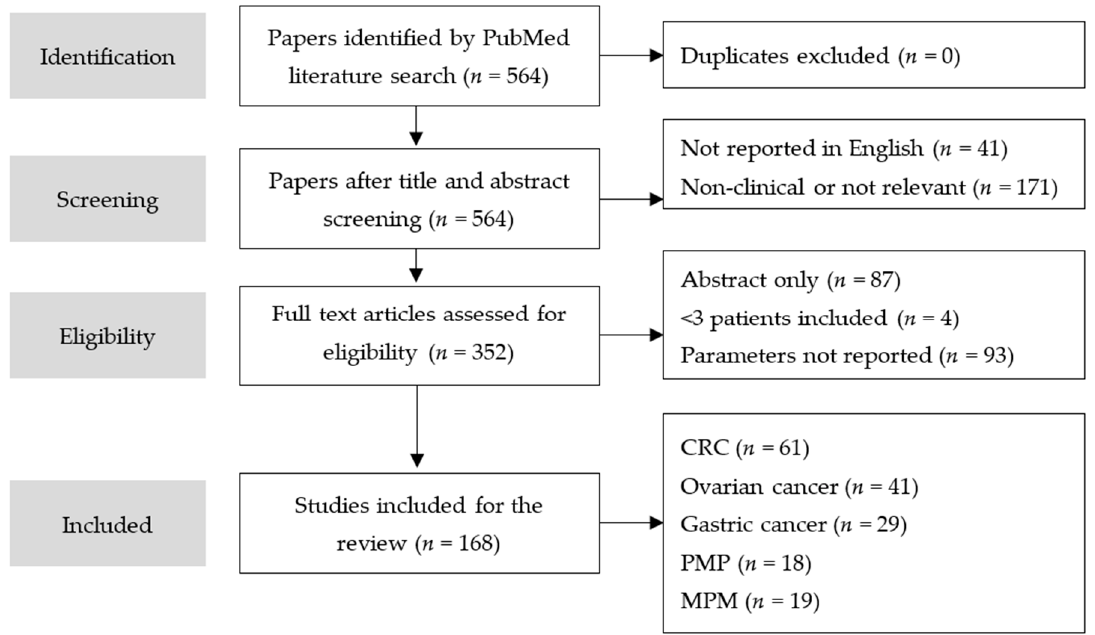
Figure 3. Flowchart literature study. CRC: 190 hits, of which 61 were included; Ovarian: 131, of which 41 were included; Gastric: 106, of which 29 were included, PMP: 46 hits, of which 18 were included; MPM: 91 hits, of which 19 were included.